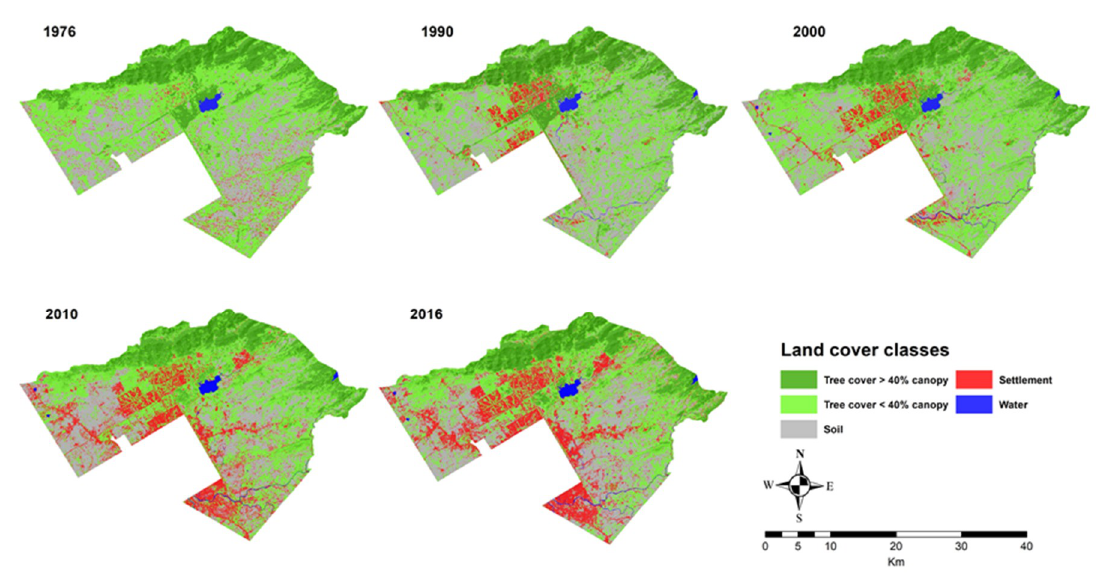
Figure 3. Land cover maps for 1976, 1990, 2000, 2010, and 2016.